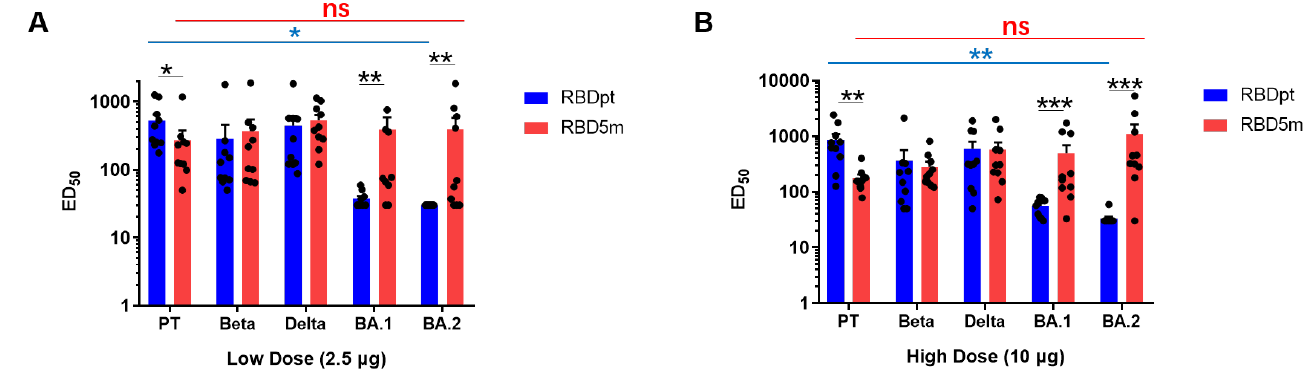
Figure 4. RBD5m elicits broad-spectrum neutralizing antibodies in mice. ( A , B ) Specific neutralization titers of the low-dose (2.5- µ g) groups ( A ) or high-dose (10- µ g) groups ( B ) of RBDpt and RBD5m against SARS-CoV-2 prototype strain (PT), Beta, Delta, BA.1, and BA.2 were determined by using pseudoviruses. ns: no significant difference; * p < 0.05; ** p < 0.01; *** p < 0.001; ED 50 : median effective dose.